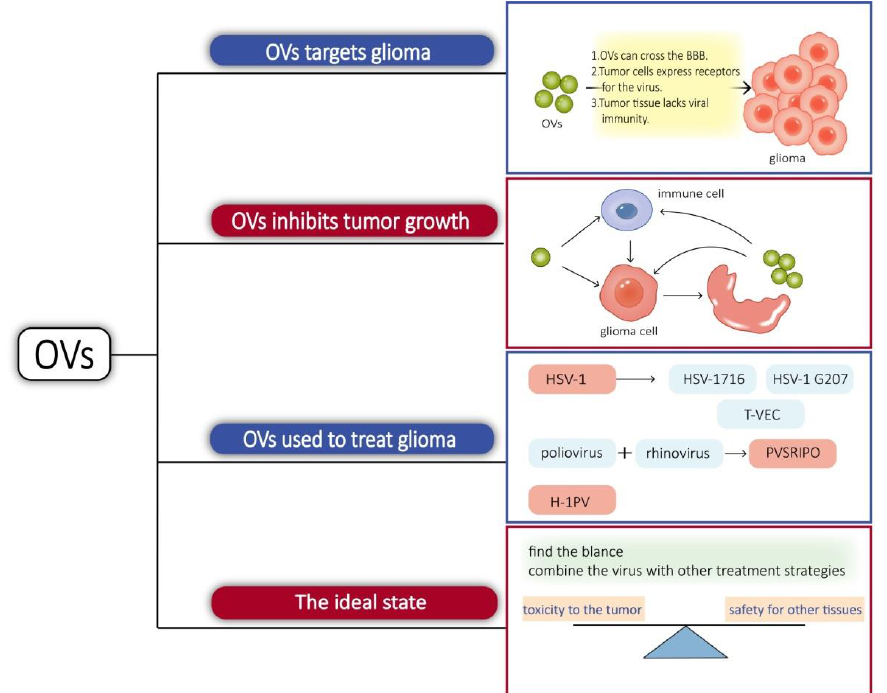
Figure 2. Some viruses can cross the BBB; some viruses can bind to receptors on the surface of glioma cells, and tumor tissue lacks immunity to viruses, so OVs tend to proliferate in glioma cells. On the one hand, OVs invade glioma cells, causing cells lysis and releasing new viruses that can invade